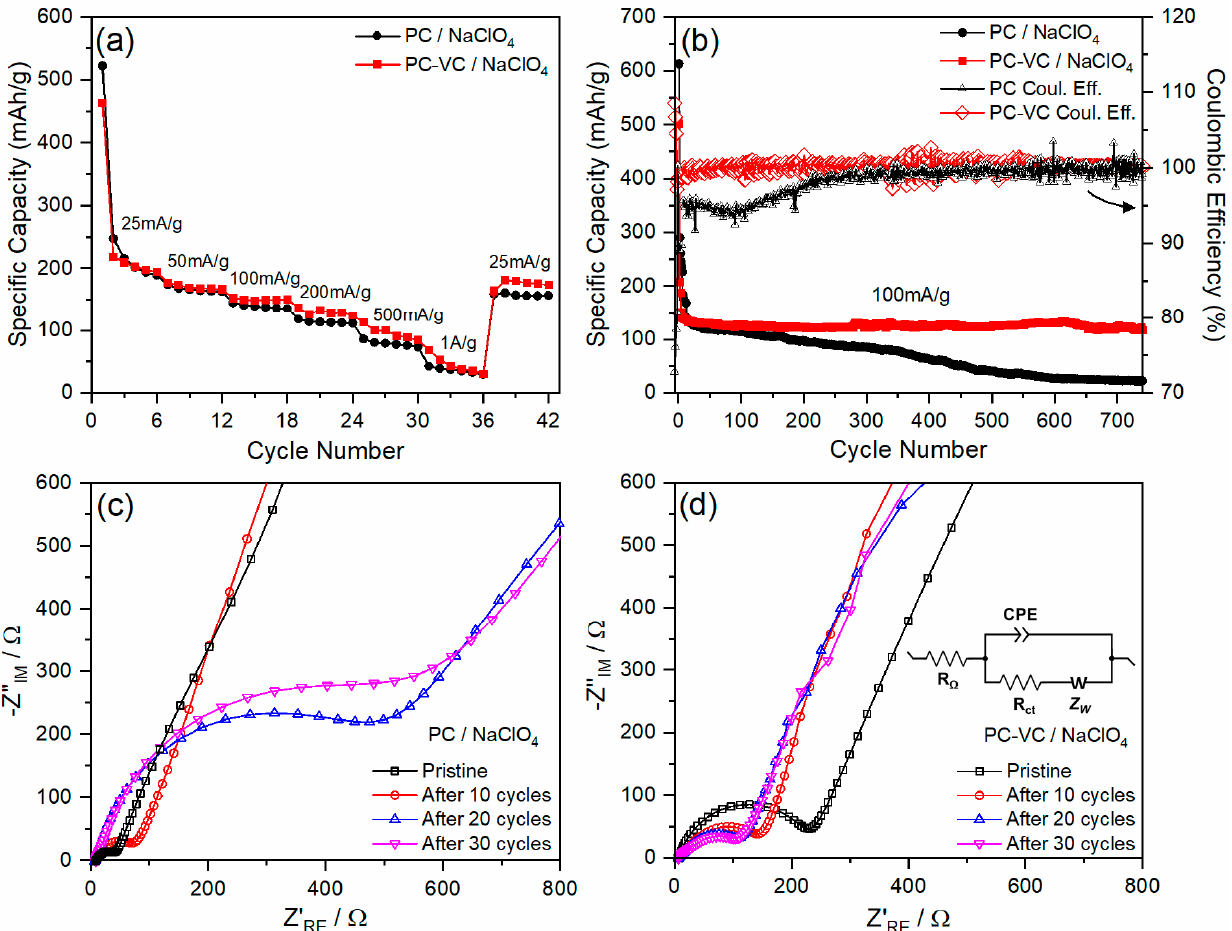
Figure 4. ( a ) Galvanostatic rate performance, and ( b ) cycling performance of TiO 2 nanosheet anodes in PC / NaClO 4 and PC-VC / NaClO 4 electrolyte solutions. Nyquist plots and equivalent circuit (inset) of TiO 2 nanosheets in ( c ) PC / NaClO 4 and ( d ) PC-VC / NaClO 4 electrolyte solutions.